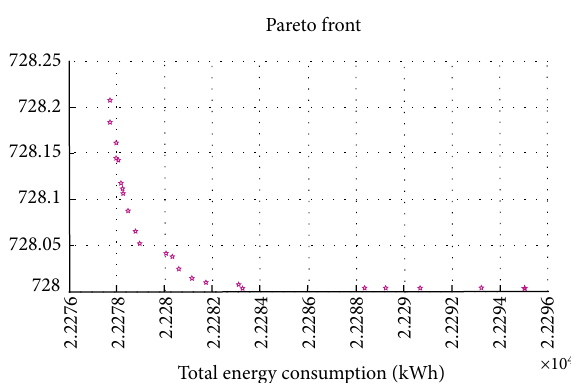
Figure 9: The Pareto solutions of